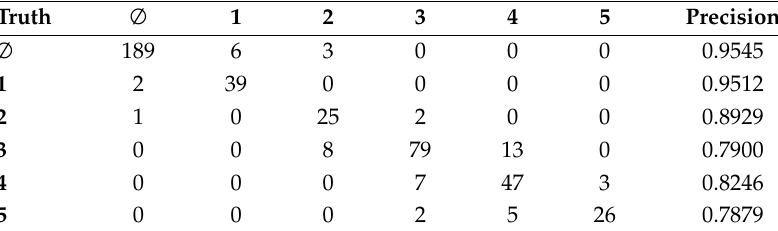
Table 5. Confusion matrix (left columns) and precision (right column) for evaluated health indices of seeding points.